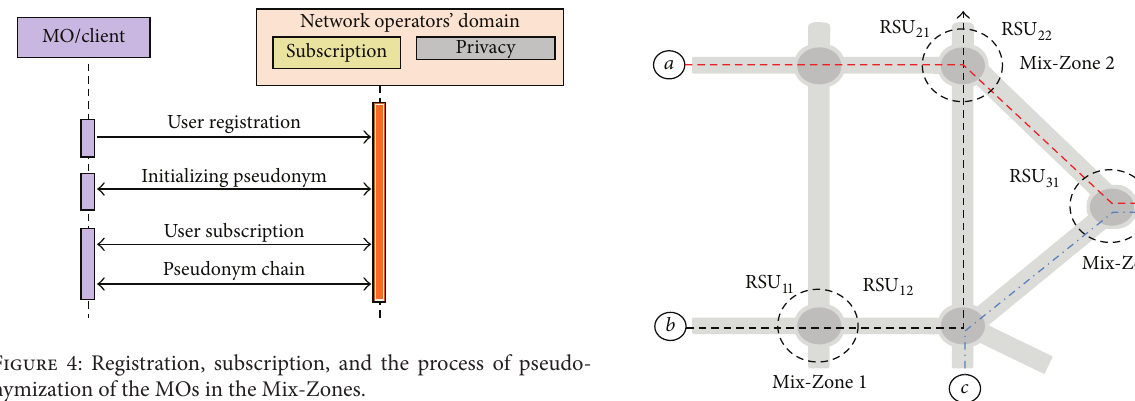
Figure5:Overviewoftheproposedsecureroadnetworkcontaining Mix-Zones (RSU: Road Side